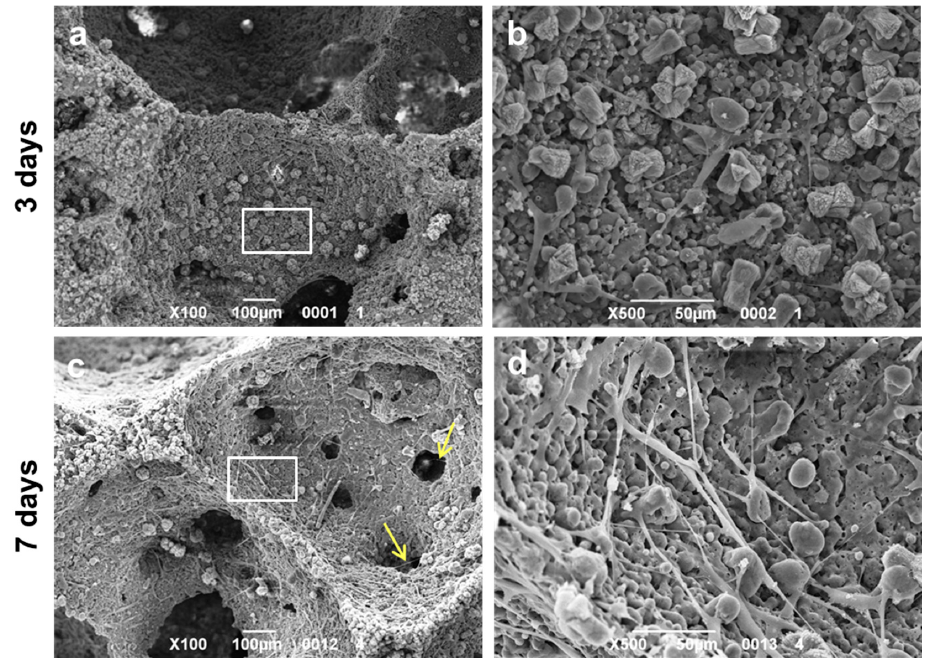
Figure 11. SEM images (100× and 500× magnification) of fibroblasts cultured on W-D glass-ceramic foam for three ( a , b ) and seven ( c , d ) days. Note that cells are able to migrate into the pores ( c , yellow arrows) of the scaffold after seven days from seeding. The white boxes in ( a , c ) represent the areas shown at higher magnification in ( b , d ).